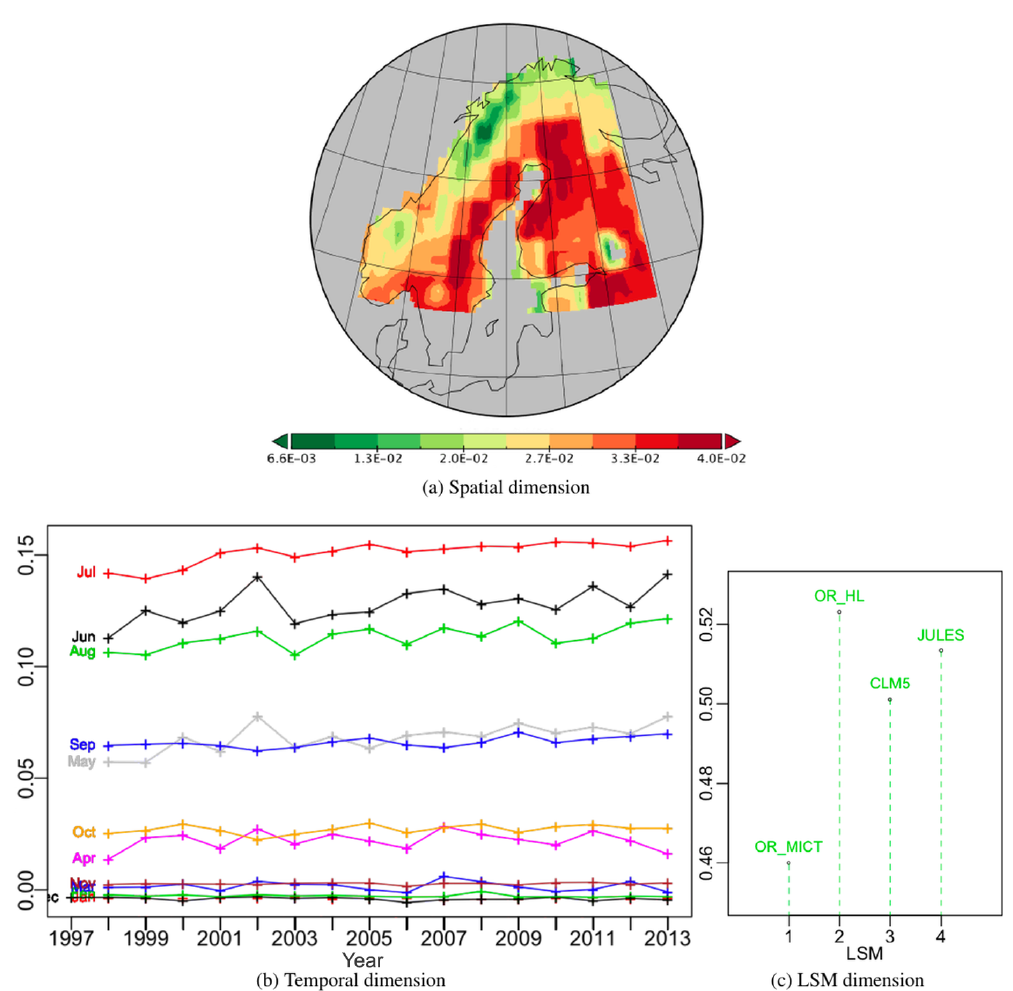
Figure 3. Plots of the components of PT -no-1 of the PTA3 decomposition in Fig. 2 representing 89.5% of the